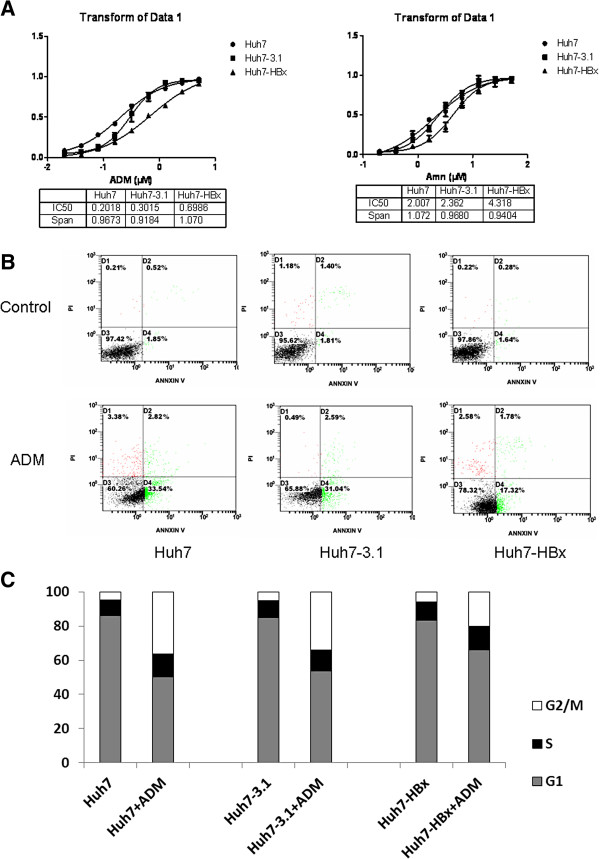
Increase in drugs resistance induced by HBx. A) The IC50 value of ADM and Amn against Huh7, Huh7-3.1, and Huh7-HBx cells respectively. Huh7-HBx cells represent a higher resistance of 2.317 and 1.828 times, respectively, than Huh7-3.1 cells against these two chemotherapeutic drugs. B) After treatment with ADM for 24 h, the Annexin V/PI assay was used for the analysis of cell apoptosis. A significantly less degree of apoptosis was found in Huh7-HBx cell than in Huh7-3.1 cell (P < 0.05). C) Cell cycle analysis of Huh7, Huh7-3.1 and Huh7-HBx cells after 24 h of treatment with ADM, as determined by flow cytometry for DNA content.